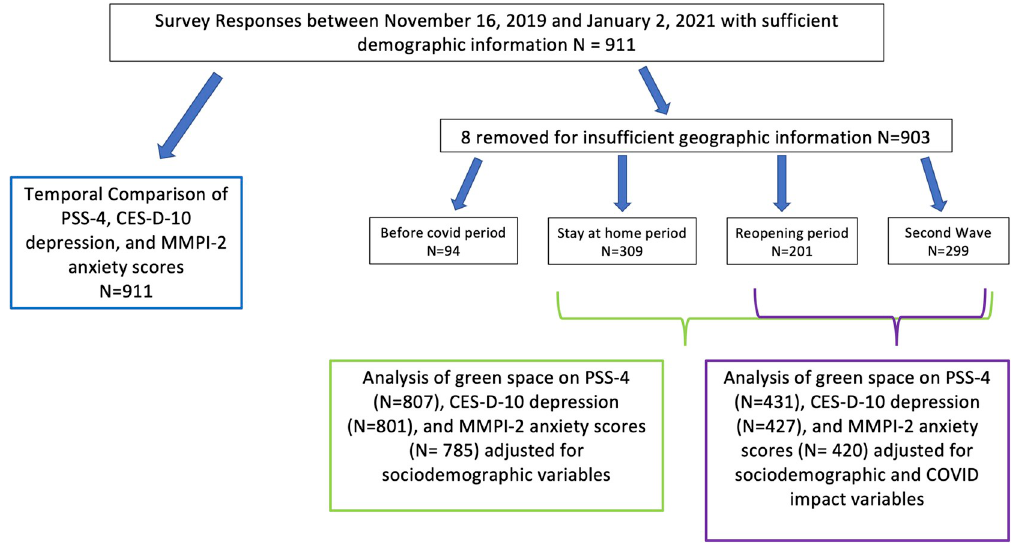
Fig 1. Flow chart of survey responses used in each